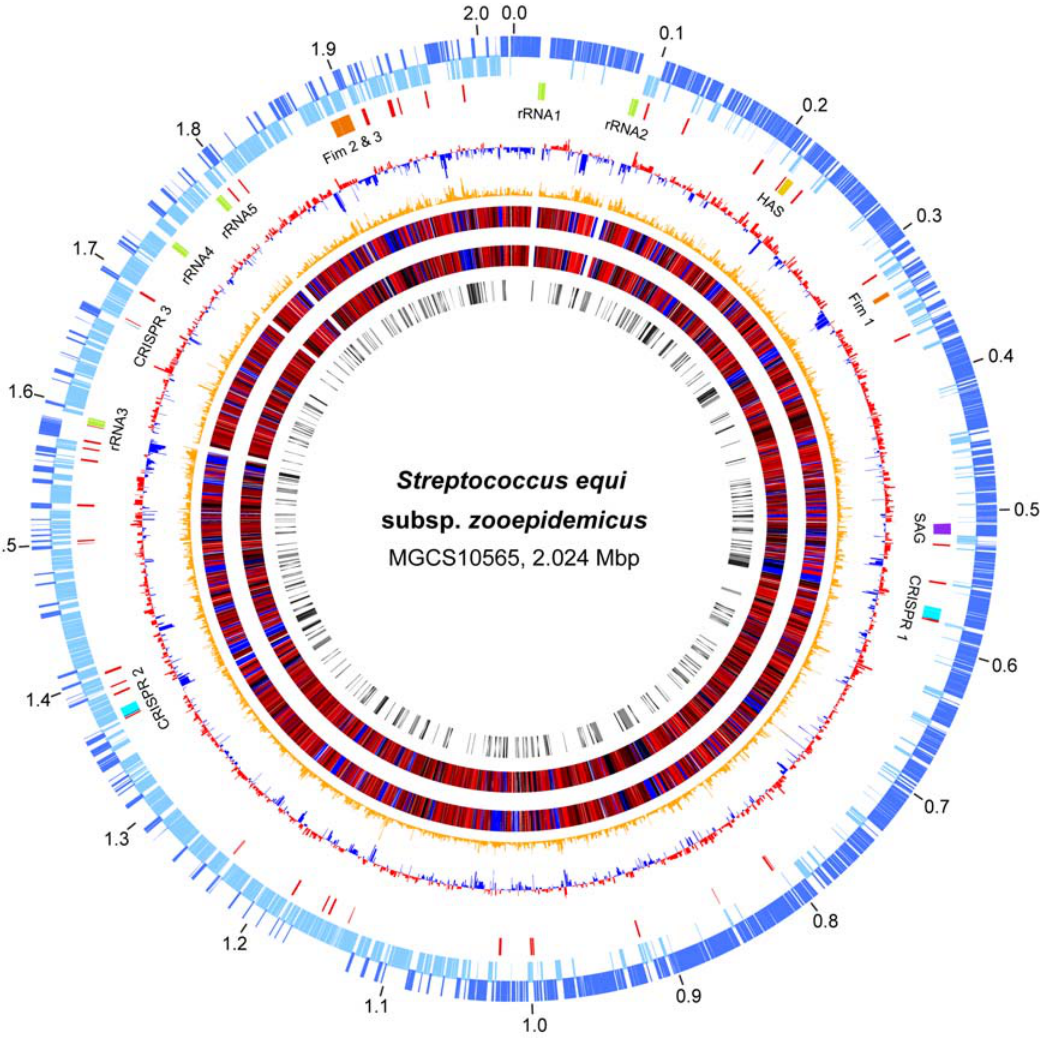
Figure 1. Genome atlas. Data from outermost-to-innermost circles are in the following order. Genome size in megabase pairs (circle 1). Annotated CDSs encoded on the forward (circle 2) and reverse (circle 3) chromosomal strands are in dark and light blue respectively. Reference landmarks (circle 4) as labeled are, ribsomal RNAs in green, fimbrial operons in orange, hyaluronic acid capsule synthesis loci in gold, CRISPR/CAS phage immunity loci in light blue, streptolysin S ( sag ) operon in purple, and ISs/transposons in red. CDS percent G + C content (circle 5) with greater and lesser than average in red and blue, respectively. Net divergence of CDS dinucleotide composition (circle 6) from the average is in orange. TBLASTN comparison of gene content with nephritogenic GAS serotype M12 strain MGAS2096 (circle 7), with high similarity in red and low in and blue. TBLASTN comparison of gene content with other sequenced streptococcal species (circle 8), with high similarity in red and low in blue. Species-specific gene content (circle 9), products not present in the other streptococcal species are in black and products sharing less than 50% amino acid identity with the most similar streptococcal homologue are in gray.